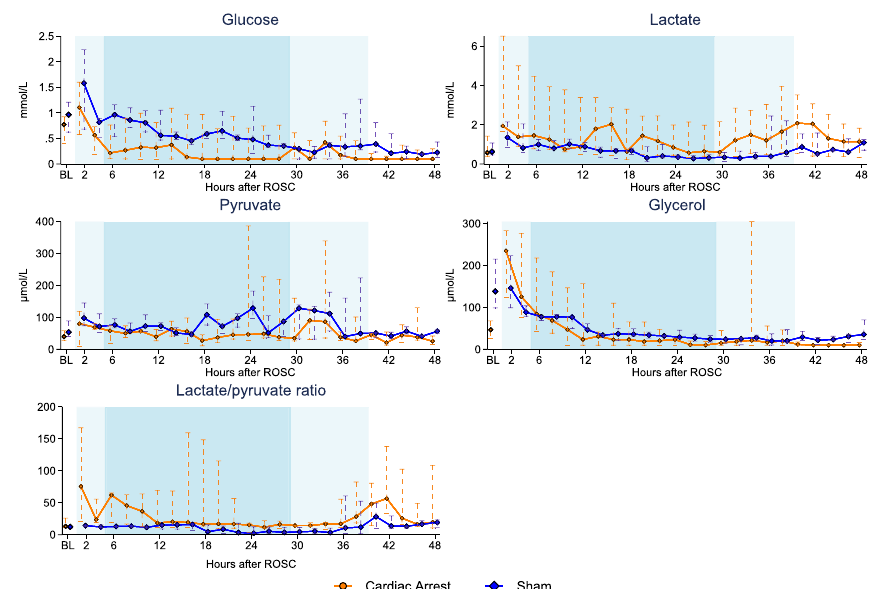
Fig. 3 Cerebral microdialysis analytes in the cardiac arrest and sham groups. Data are presented as median [25%; 75%]. Lighter blue shading indicates induction or rewarming phase, while darker blue shading indicates maintenance phase of targeted temperature